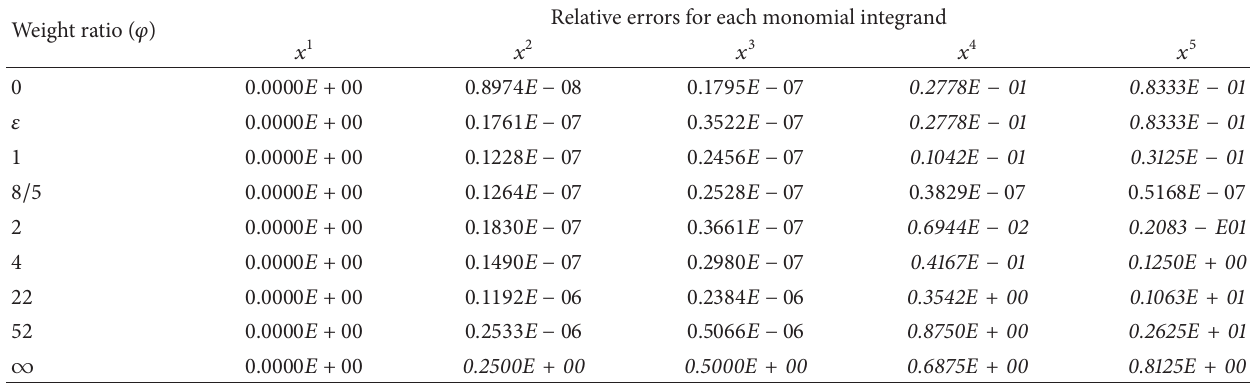
Table 2: Relative errors of the different types of 3-point Gauss integration of variable sampling pints for 5 monomial integrands.